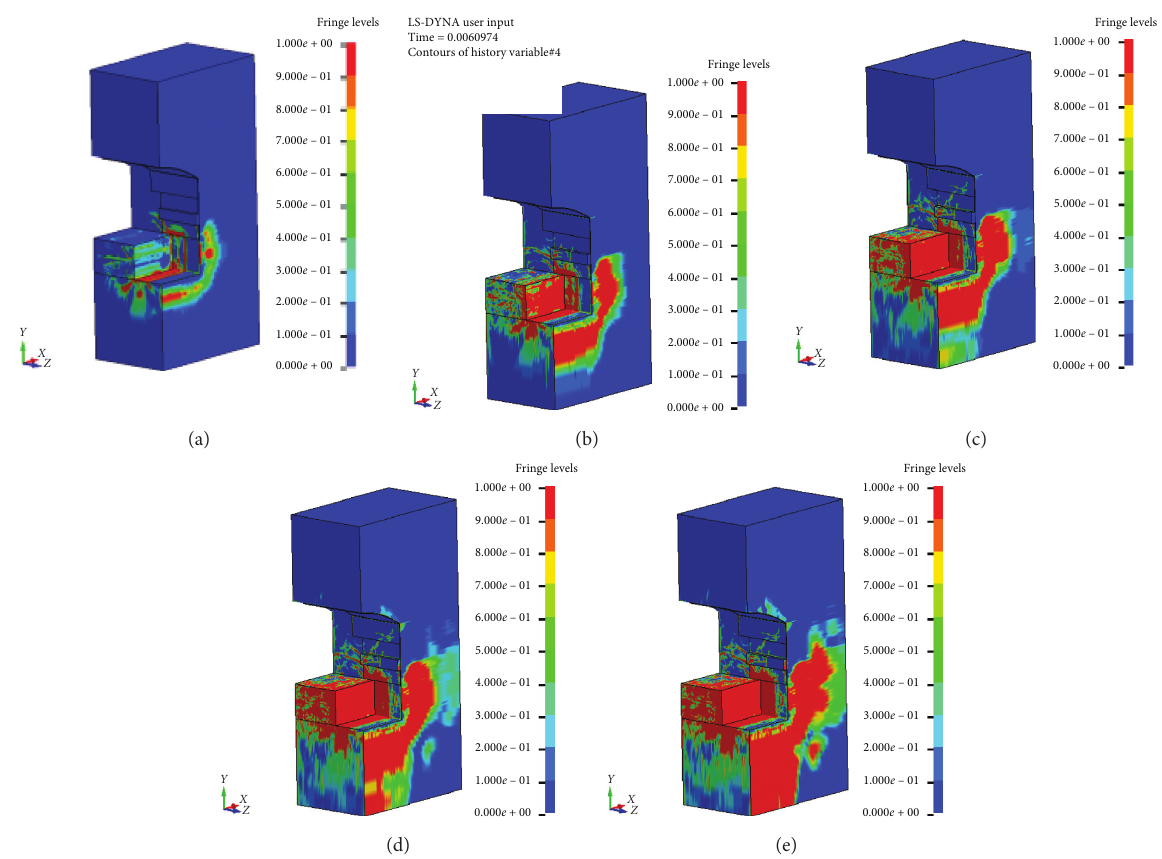
Figure 8: Cumulative damage nephogram of surrounding rock and rock anchor beam concrete under blasting. (a) 3.1 ms, (b) 6.1 ms, (c) 9.1 ms, (d) 12.1 ms, and (e) 15.0 ms.